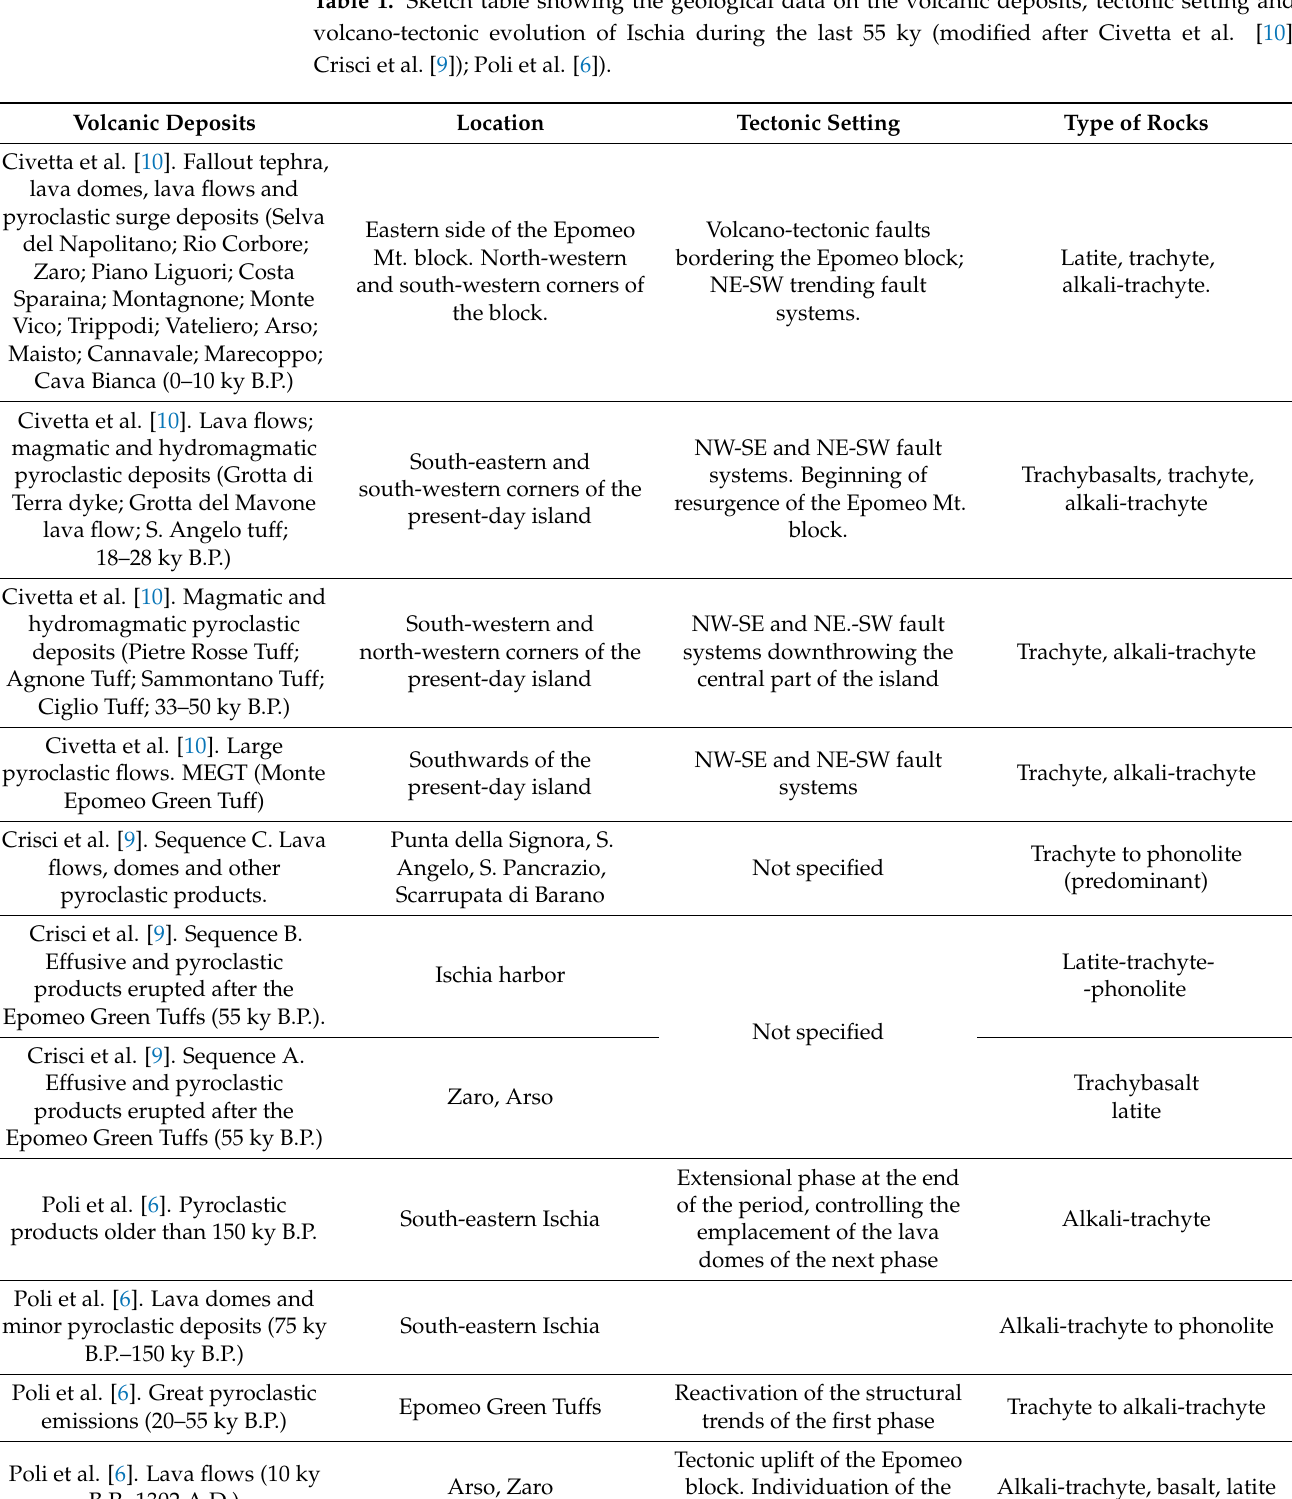
Table 1. Sketch table showing the geological data on the volcanic deposits, tectonic setting